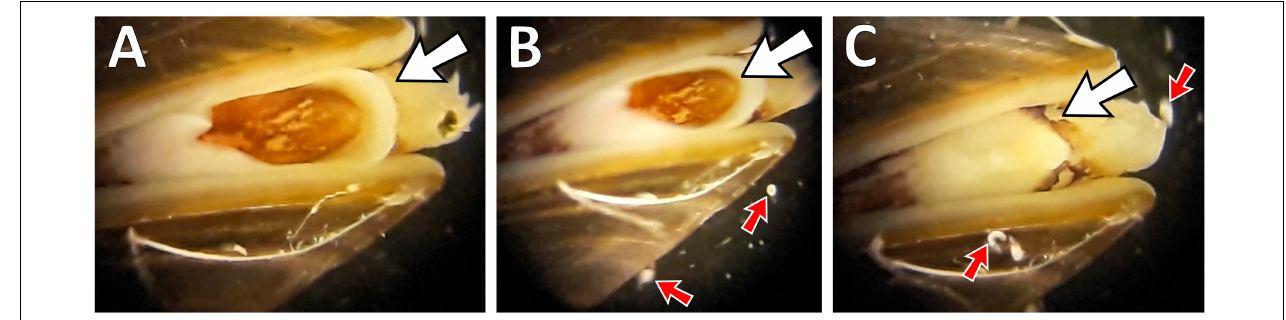
FIGURE 2 | Photo series of Mytilus edulis reacting to Himasthla elongata cercariae in the water observed under laboratory conditions. (A) Mussel filtering with exhalant siphon (white arrow) wide open. (B) Cercariae of H. elongata (small red arrows) swarming around the mussel. (C) Mussel retracting exhalant siphon and ceasing filtration